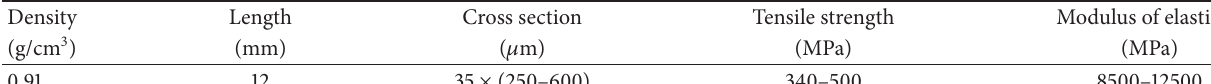
Table 3: Properties of the used polypropylene fibres.